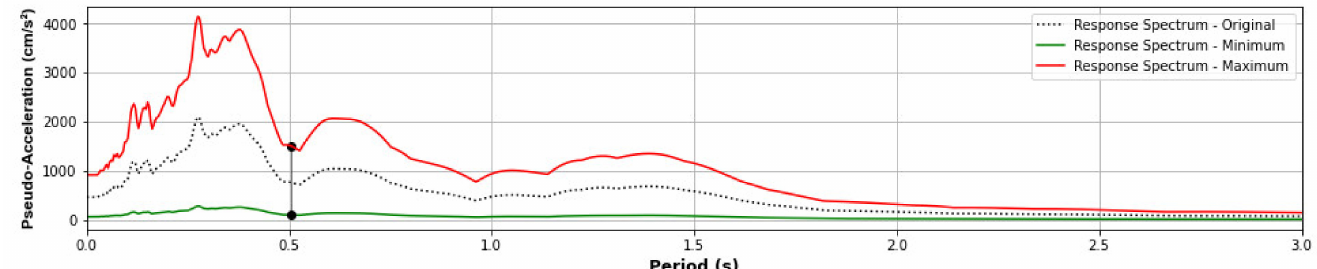
Figure 19. Acceleration response spectra of the “Loma Prieta” input ground motion. The red line is with the maximum scale factor such that it produces Sa(T 1 ) = 1500 gal, the green line is with the minimum scale factor such that it produces Sa(T 1 ) = 100 gal, and the black dashed line considers the original input ground